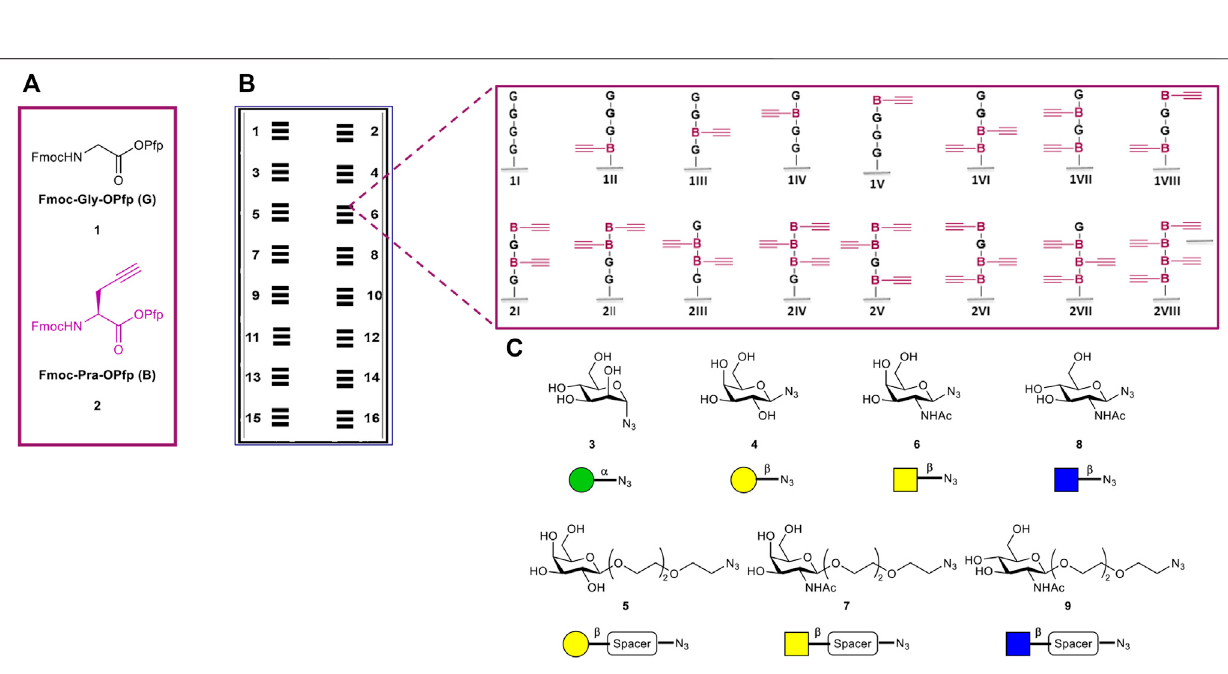
Frontiers in Chemistry |